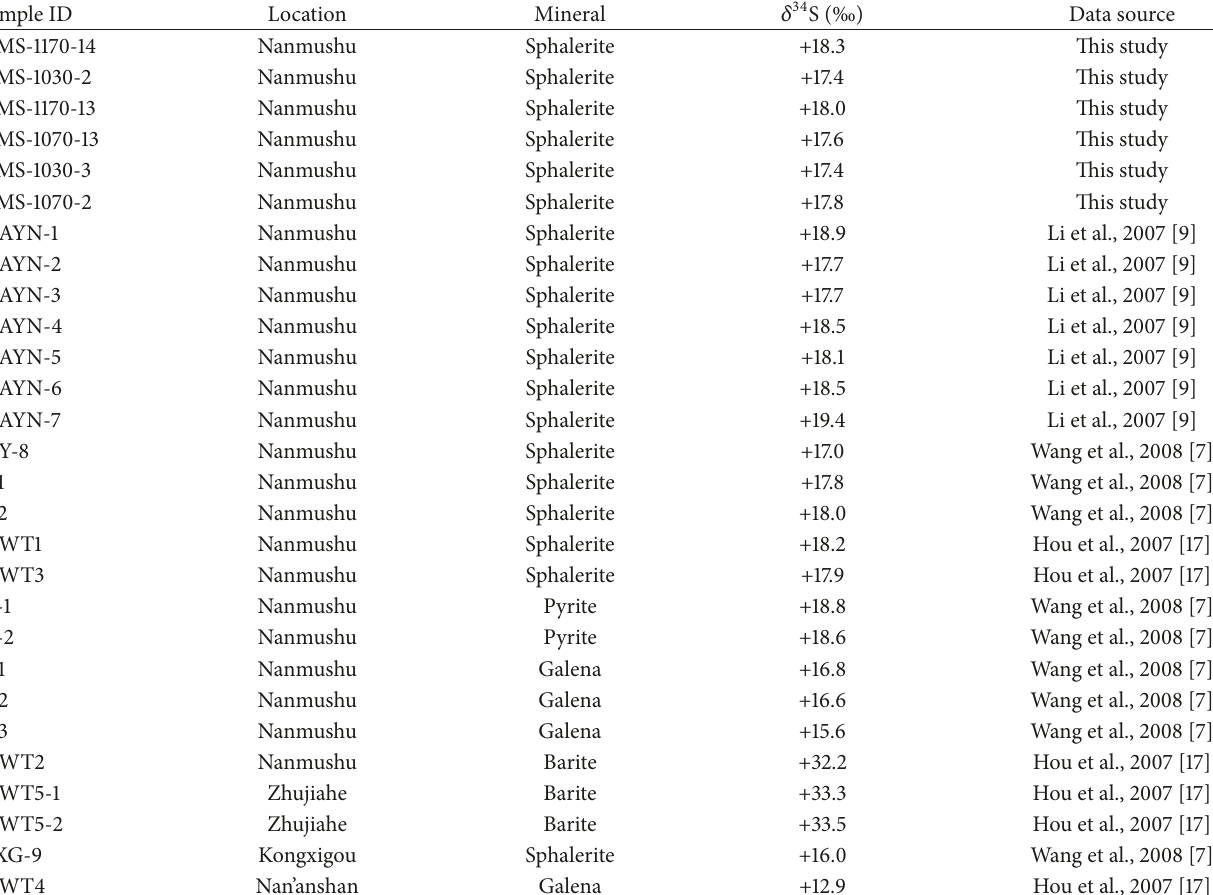
Table 3: Sulfur isotopic data of sulfides and sulfate from the Mayuan